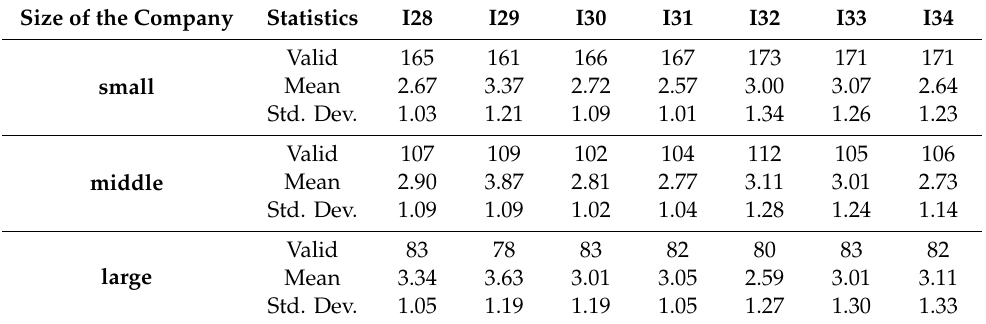
Table 11. Average scores of items in the phase of talent development according to size of the company. Size of the Company